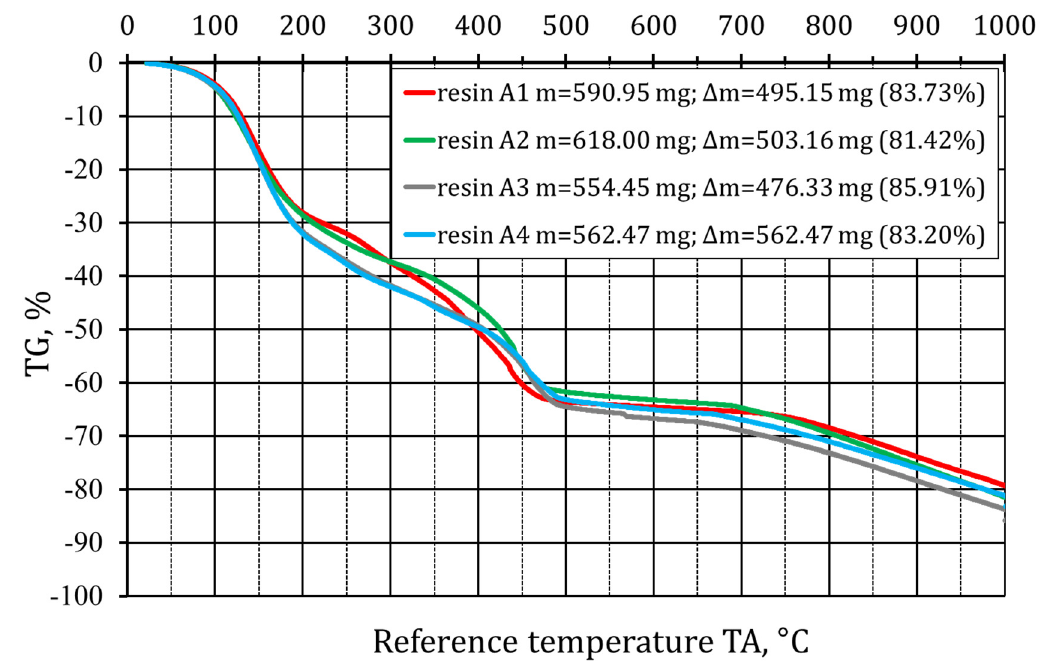
Figure 2. Thermal analysis of the tested alkali-phenolic binders.